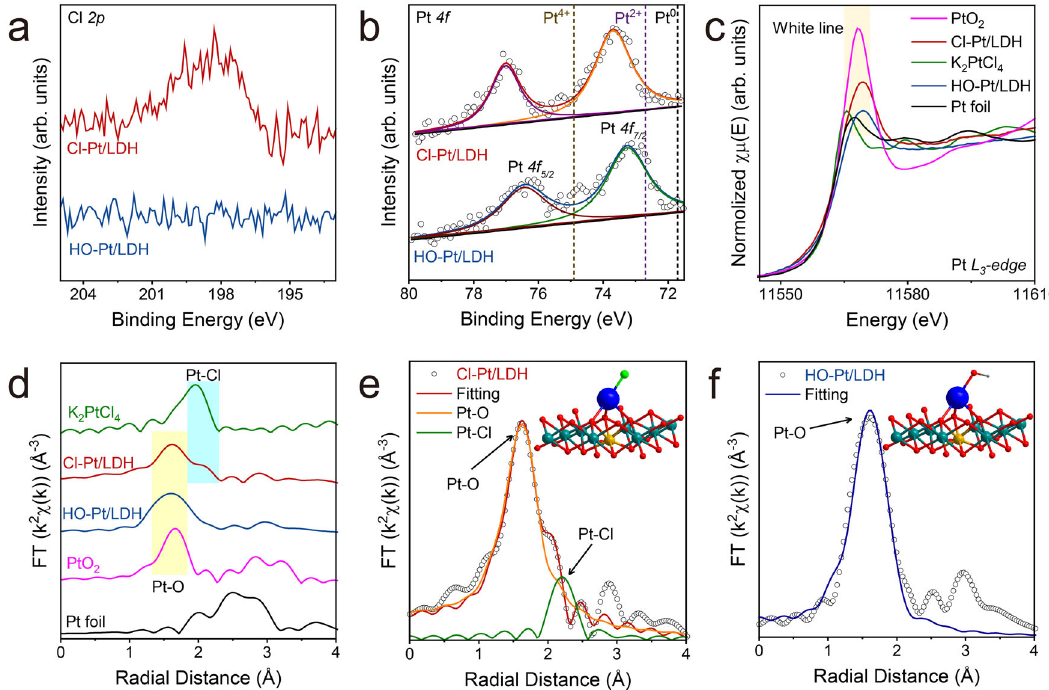
Fig.2|Characterizationsoftheelectronicstateandcoordinatestructure.High resolution XPS spectra of Cl 2p. a and Pt 4f ( b ) for Cl-Pt/LDH and HO-Pt/LDH. c XANES spectra of Cl-Pt/LDH, HO-Pt/LDH, Pt foil, K 2 PtCl 4 and PtO 2 at the Pt L 3 - edge. d CorrespondingFT-EXAFSspectra.RepresentativeEXAFS fi ttingcurve(inset